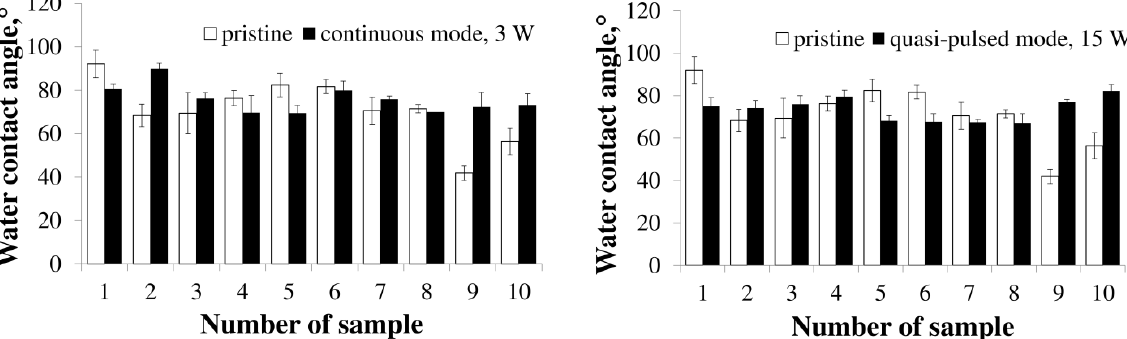
Figure 5. The effect of the composition of 2-component PHAs on the value of the contact angle after laser treatment in continuous and quasi-pulse modes (numbering — Table 1): 1 — P(3HB); 2 – 4 — P(3HB- со -3HV); 5 – 7 — P(3HB- со -4HB); 8 – 10 — P(3HB- со -3HHx).